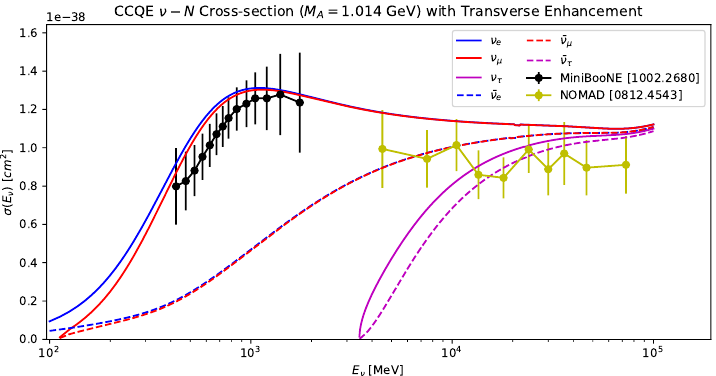
Figure 13 . The charged current quasi-elastic (CCQE) cross-section per nucleon is plotted by integrating eq. (A.1) for each neutrino species. Only the (cid:23) (cid:22) scattering cross-section is used in this work to predict (cid:23) (cid:22) scattering rates at DUNE, for energies between 100 and 1000 MeV. The NOMAD [65] and MiniBooNE [66] measurements of the (cid:23) (cid:22) cross-section are overlayed.